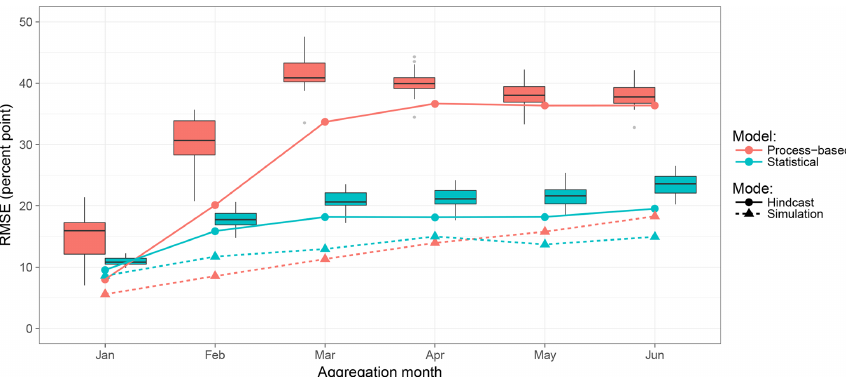
Figure 6. RMSE of regional reservoir storage hindcasts with increasing forecast horizon and lead time. Monthly values are obtained by aggregation over the full analysis period (1986 to 2014) for a specific month. Each box reflects the distribution of the 20 ensemble members. Coloured solid lines refer to the ensemble median taken as the deterministic forecast and analysed individually.